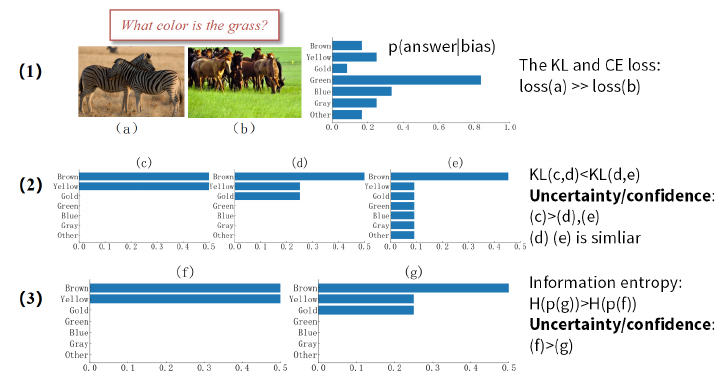
Figure 4. Examples used to show the difference between KL divergence and